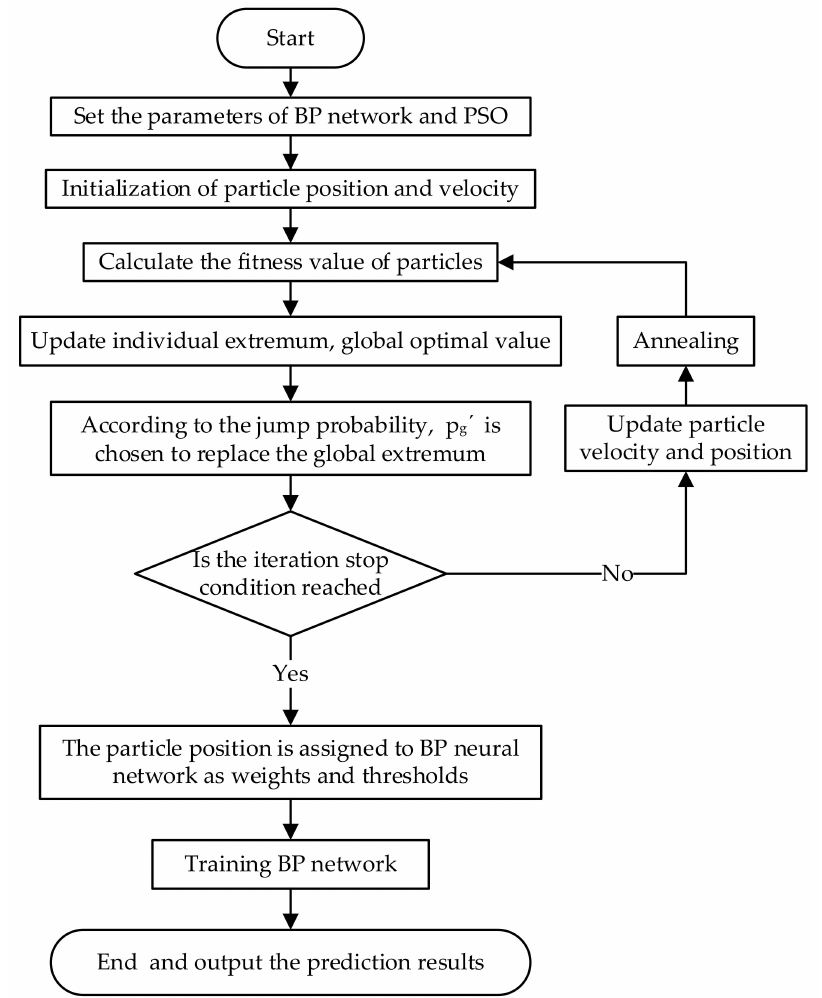
Figure 4. SAPSO-BP algorithm flow